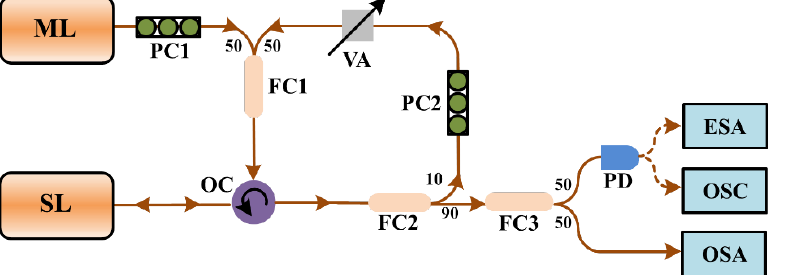
Figure 1. Schematic of the experimental setup. ML: master laser, SL: slave laser, PC: polarization control, FC: fiber coupler, OC: optical circulator, VA: variable attenuator, PD: photodetector, ESA: electrical spectrum analyzer, OSA: optical spectrum analyzer, OSC: oscilloscope.